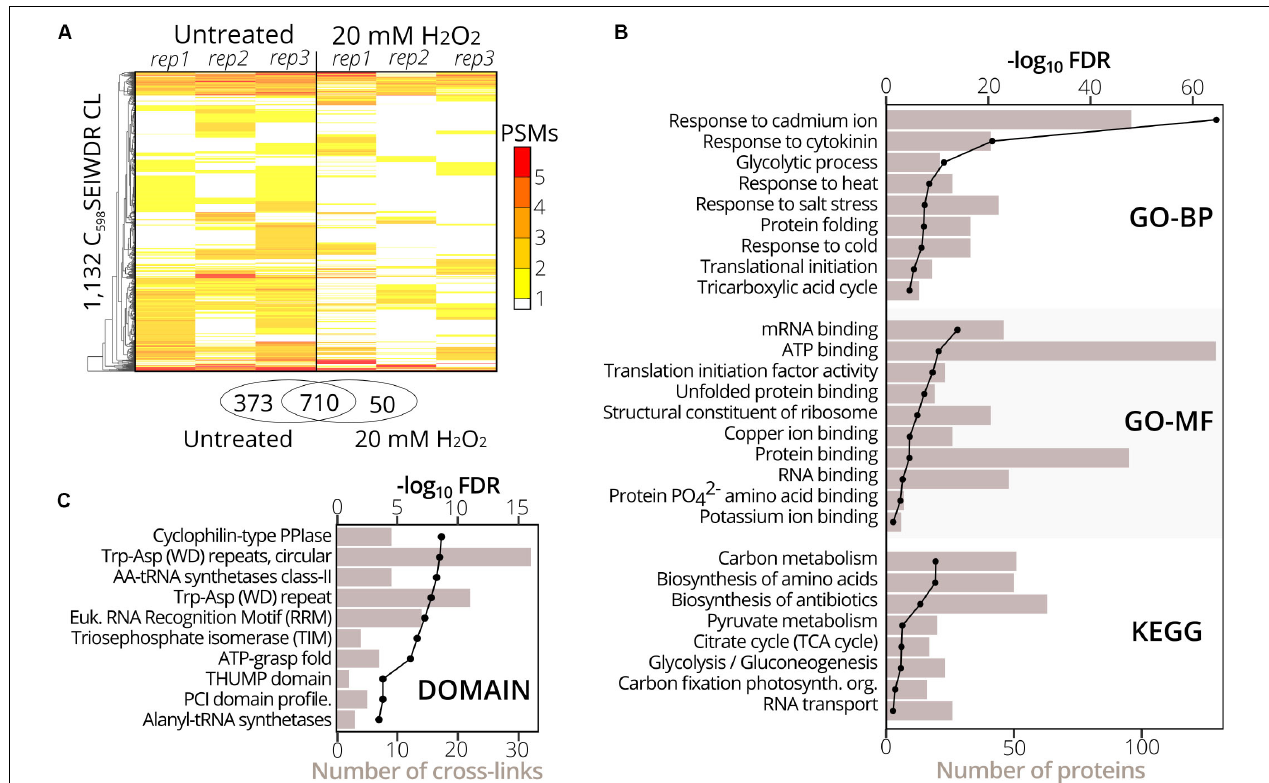
FIGURE 2 | Gene set and protein domain enrichment of YAP1C C 598 SEIWDR CL proteins and sites. (A) Heatmap of the 1,132 C 598 SEIWDR CL peptides (FDR ≤ 1%; ≥ 2 PSMs) showing the number of PSMs per replicate in cells untreated (left) and treated with H 2 O 2 for 30 min (right). The overlap of C 598 SEIWDR CL peptides between conditions is shown in a Venn diagram. (B) Gene set enrichment of the 570 proteins matched uniquely by the C 598 SEIWDR CL peptides with the DAVID tool (Huang et al., 2009). The assessed gene sets were KEGG pathways, gene ontology (GO) terms for biological process (GO-BP), molecular function (GO-MF), and cellular component (GO-CC, not plotted). All results are presented in Supplementary Dataset S3A . (C) Enrichment of 1,132 sulfenylated cysteines in PROSITE profiles (see section “Materials and Methods”). Enrichment was plotted as a black line (-log 10 FDR, top x -axis) and the number of CL sites as a bar chart (bottom x -axis). All results are reported in Supplementary Dataset S3B